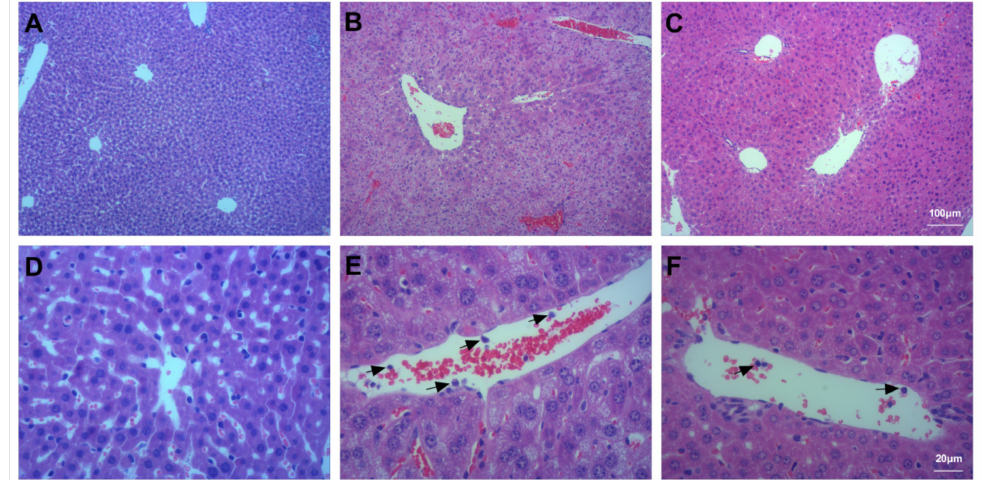
Figure 7. Histological assessment of the liver tissue: ( A ) Con group; ( B ) Bl group; ( C ) Bl + MSC group; ( D ) Con group; ( E ) Bl group; ( F ) Bl + MSC group. Black arrows indicate neutrophils ( A – C , 100 × magnification; D – F , 400 ×